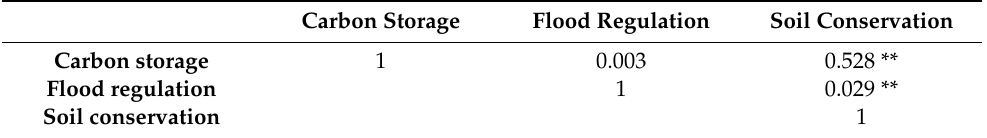
Table 4. Correlation analysis between pairs of ecosystem services in ecological conservation area in the year 2015. Supplementary data for the correlation analysis in the year 2030 under di ff erent scenarios are in Supplementary Table